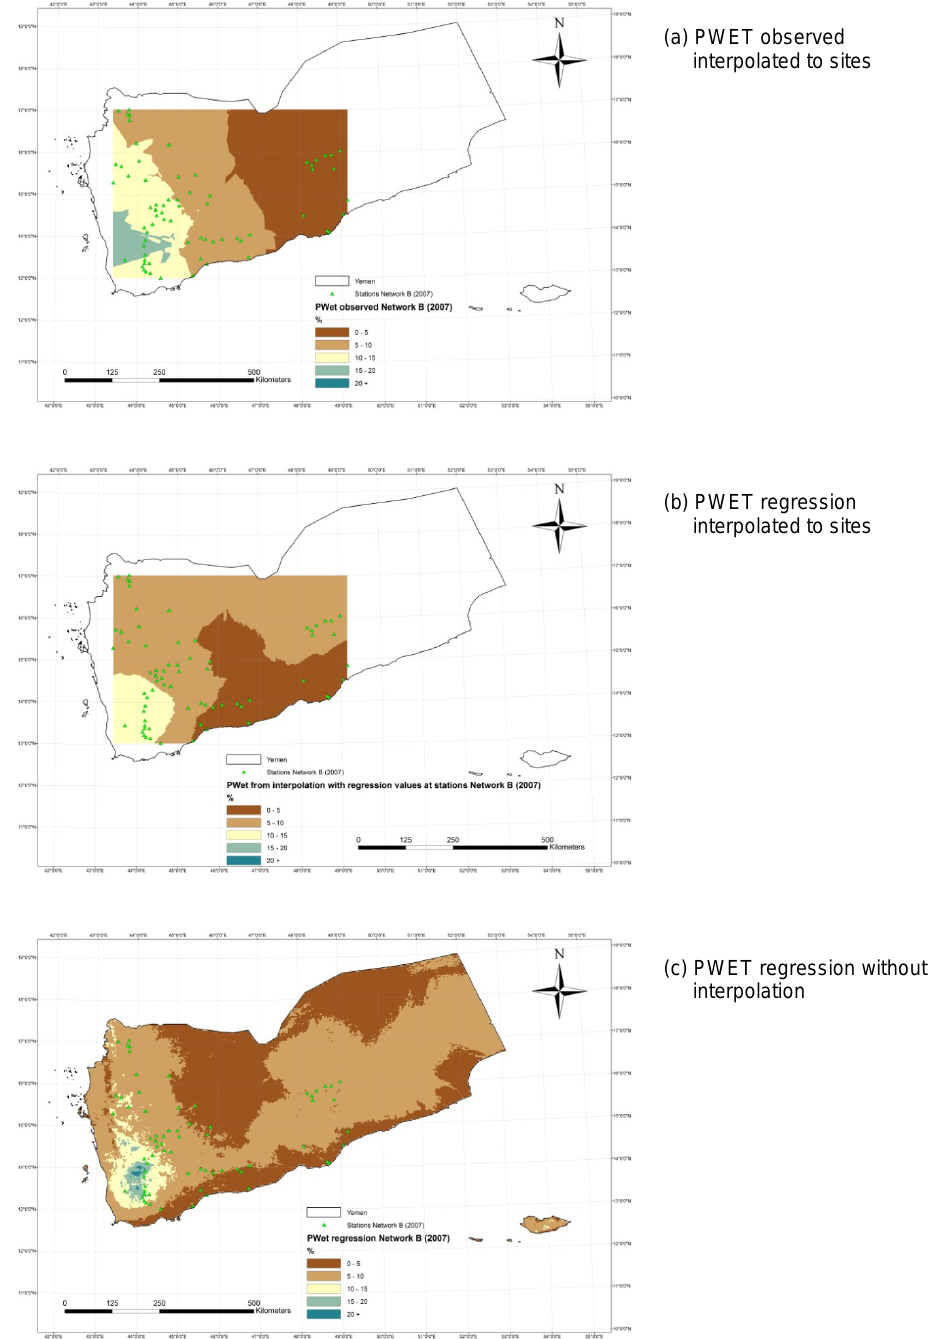
Fig. 10. As in Fig. 9 but for Network